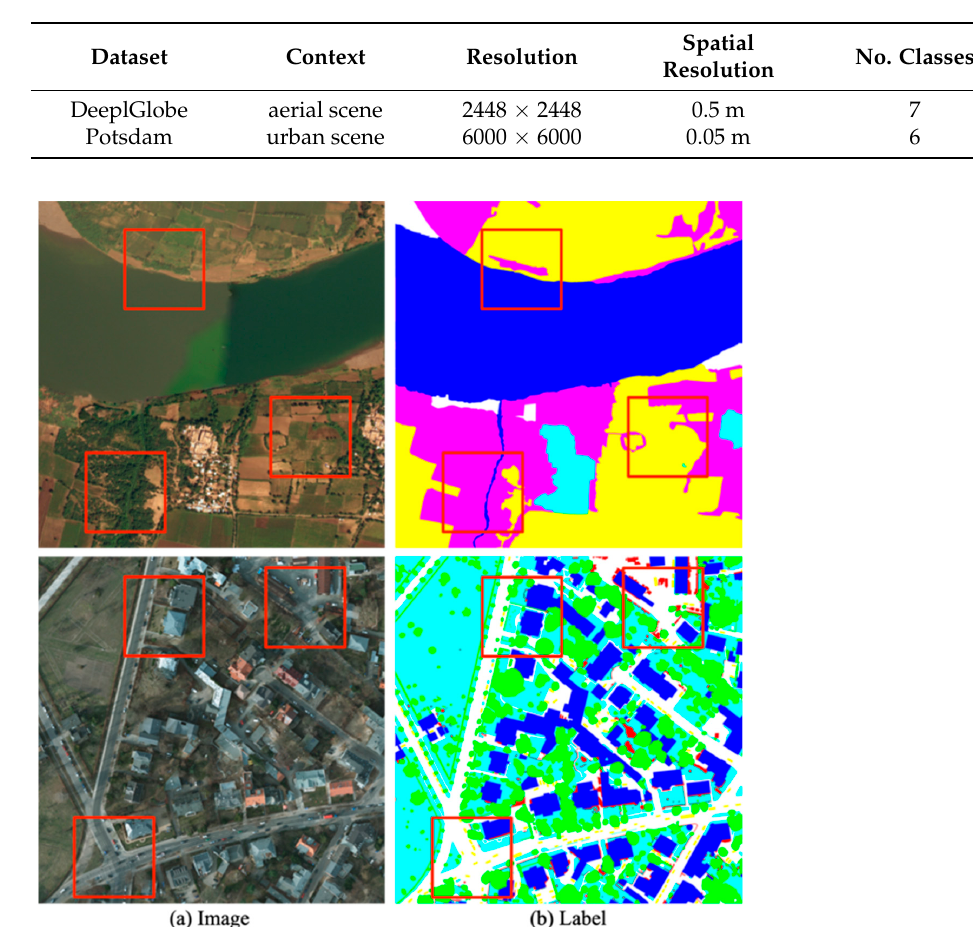
Table 1. Details of HSR Datasets used to evaluate of framework.